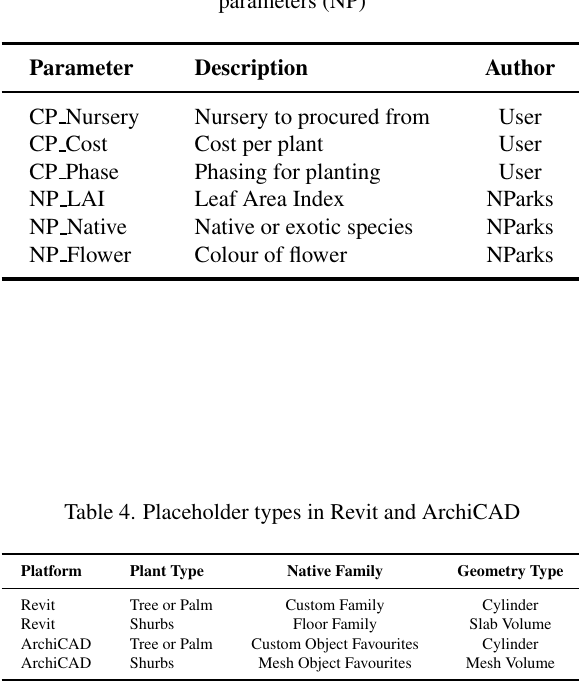
Table 3. Examples of custom user parameters (CP) and NParks